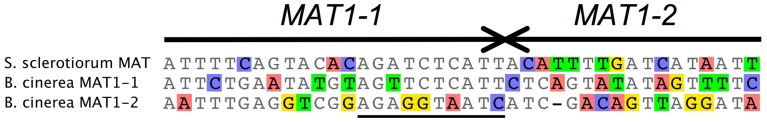
Proposed MAT1-1 – MAT1-2 border in S. sclerotiorum MAT inferred from an alignment of S. sclerotiorum MAT, B. cinerea MAT1-1 and MAT1-2.
The location of the alignment reproduced above is indicated in Figure 4 by an asterisk, for entire alignment see Alignment S3. Sclerotinia sclerotiorum strain 44Ba1 MAT (GenBank Accession JQ815883) and B. cinerea MAT1-1 (AAID01003685) were alignable up to 248 bp downstream of S. sclerotiorum MAT1-1-1 as indicated by the top left arrow, homology ceases thereafter. The site where a crossover between ancestral MAT1-1 and MAT1-2 represented here by B. cinerea MAT1-1 and MAT1-2, might have occurred, is underlined. The border and crossover site positions are tentative, since S. sclerotiorum MAT and B. cinerea MAT1-2 (reverse complement of FQ790352) were too divergent to be aligned in the MAT1-2-4 downstream region (Figure 1), the top right arrow demarcates the MAT1-2 region in S. sclerotiorum based on lack of homology to B. cinerea MAT1-1, not based on homology to B. cinerea MAT1-2.